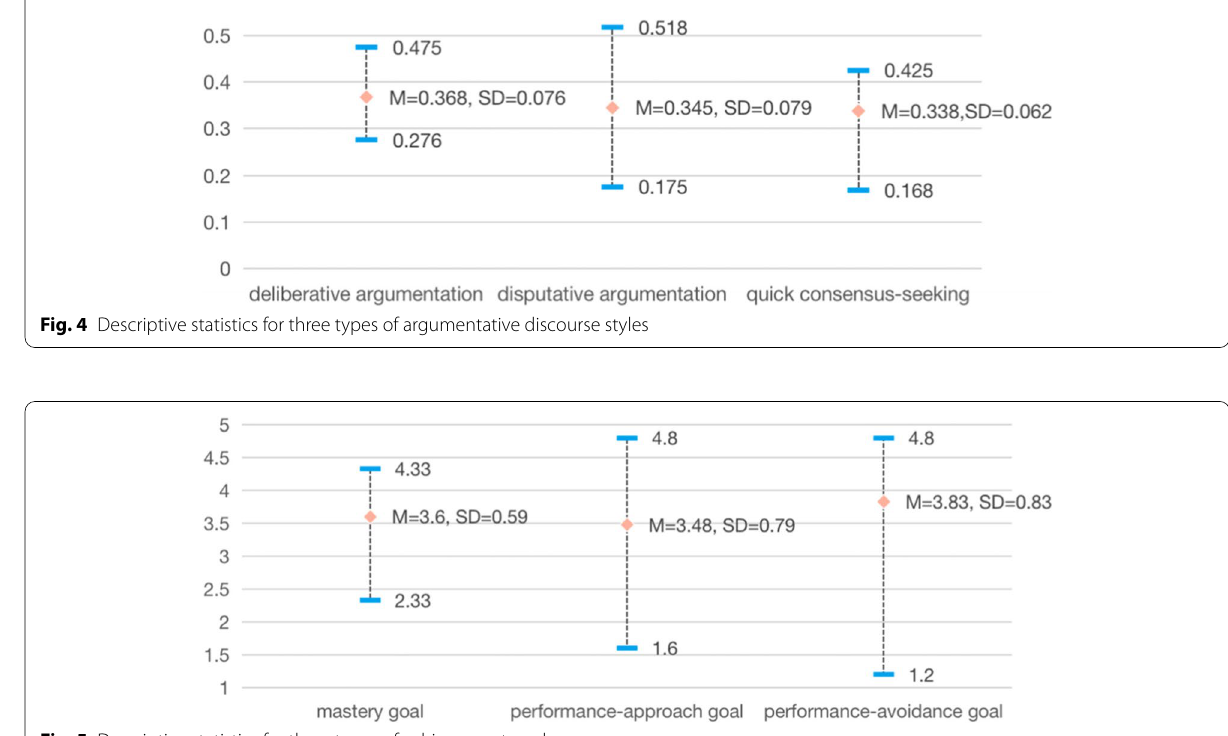
Fig. 5 Descriptive statistics for three types of achievement goals